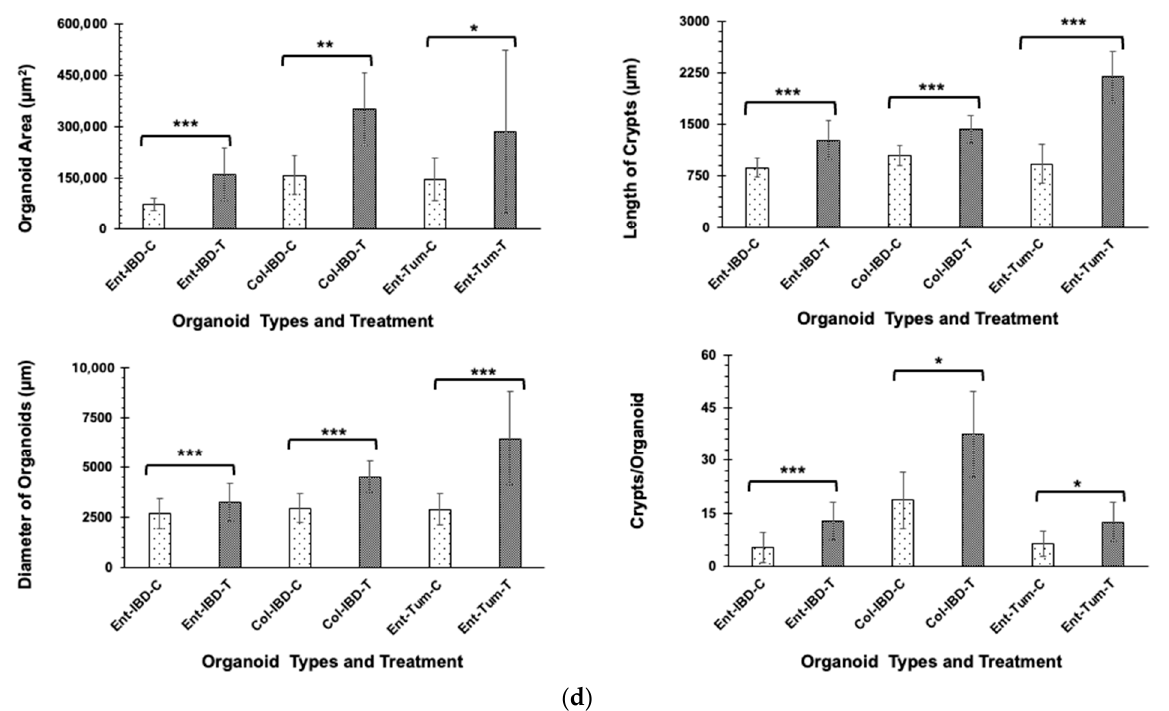
Figure 1. LPS stimulates higher proliferation. ( a ) Enteroids and colonoids from dogs with IBD and intestinal mast cell tumor, 48 h after LPS stimulation. Representative phase-contrast images of enteroids and colonoids after LPS stimulation. The control group received complete growth medium, whereas the LPS group received LPS 5 µ g/mL in complete growth medium. ( b ) Expression of Ki-67 in enteroids and colonoids from dogs with IBD and intestinal mast cell tumor, 48 h after LPS stimulation as measured by qPCR. The control group received complete growth medium, whereas the LPS group received LPS 5 µ g/mL in complete growth medium. GAPDH was used to normalize.